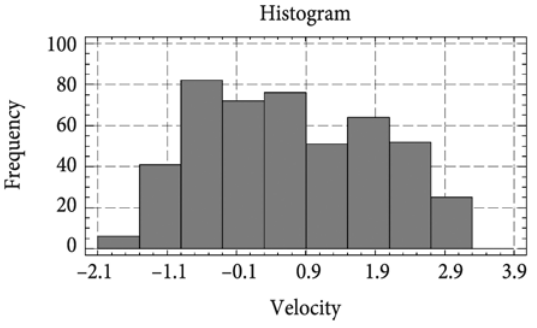
Fig. 3. Frequency of the repetition of digital values of velocities in Jonava–Zarasai–Turmantas–Vilnius